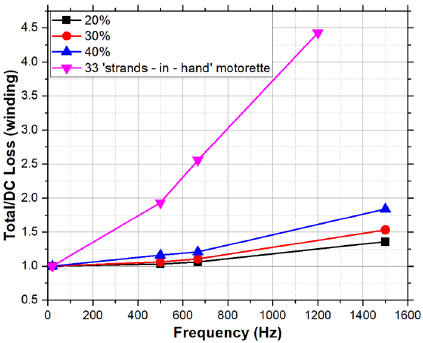
Figure 11. Comparison of Total/DC Loss ratio of the